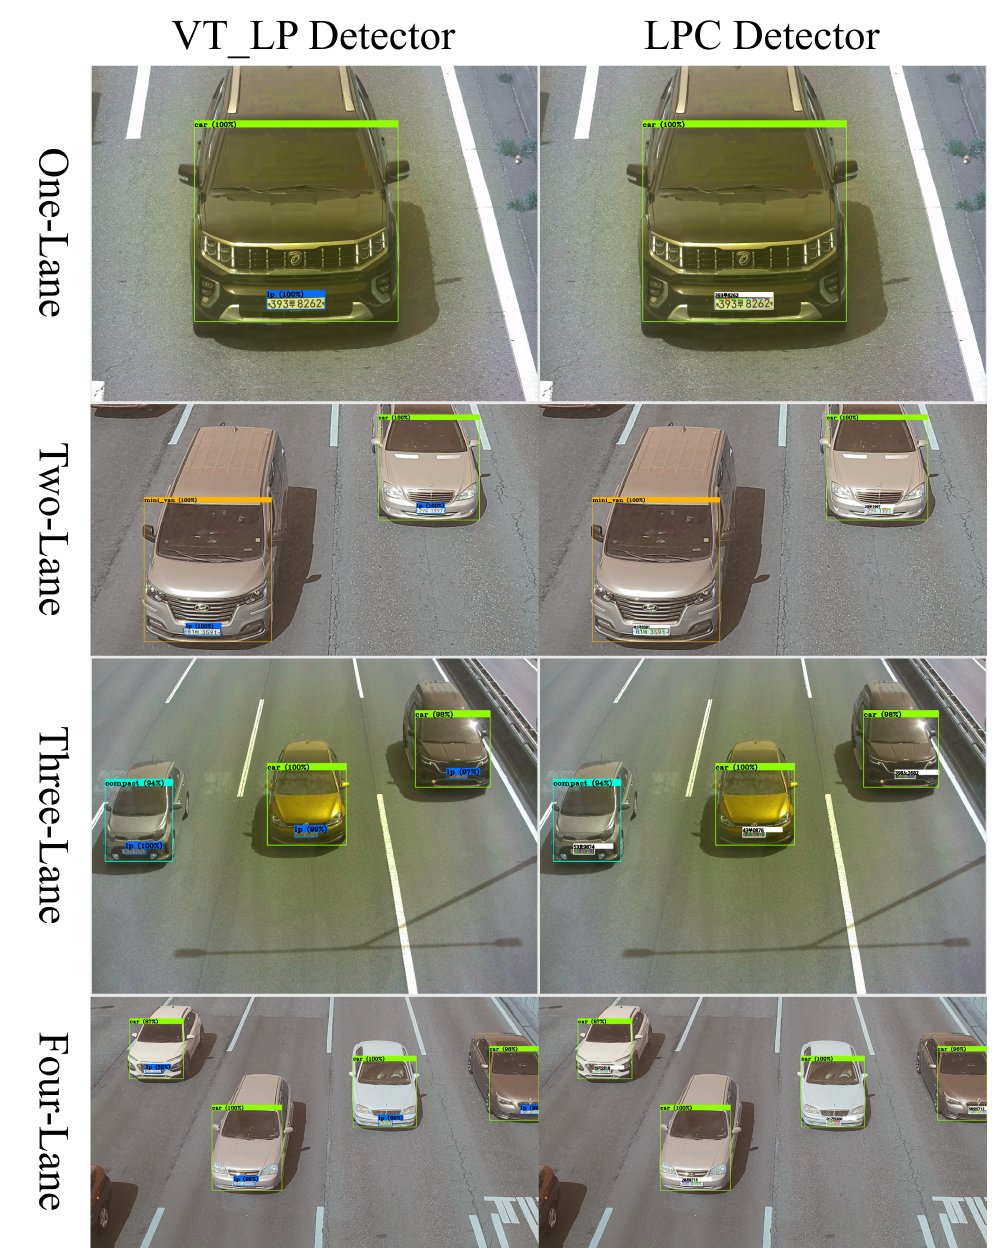
Figure 12. Examples of multilane test images for measuring detection speed. Table 6. Detection speed on a PC with